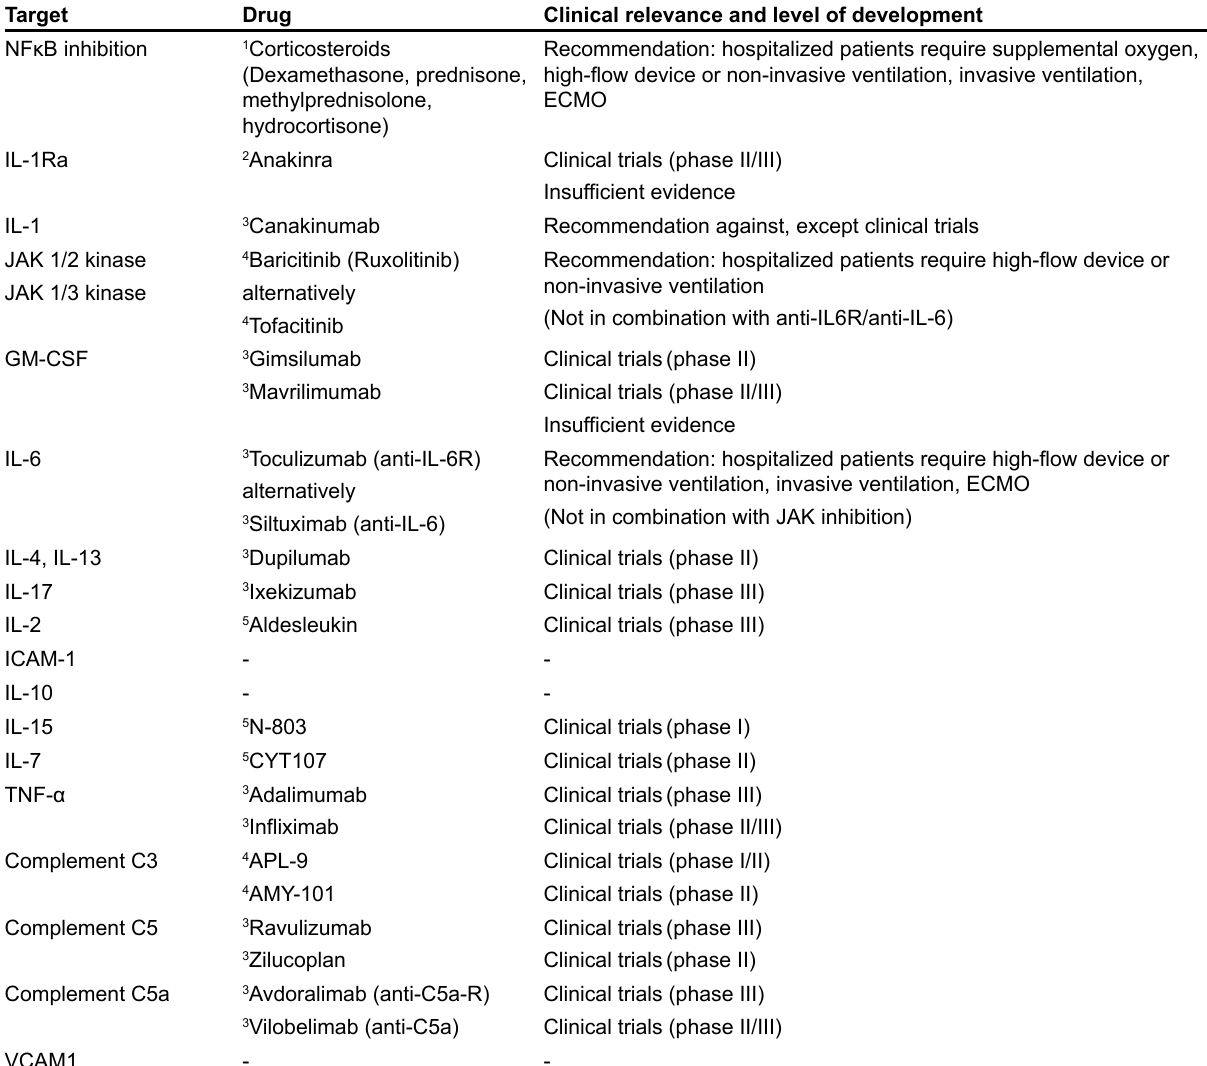
Table 2. Recommendation of immune-modulating therapeutics according to NIH COVID-19 treatment guidelines as of November 2021 [16] and current status of clinical development according to ClinicalTrials.gov as of December